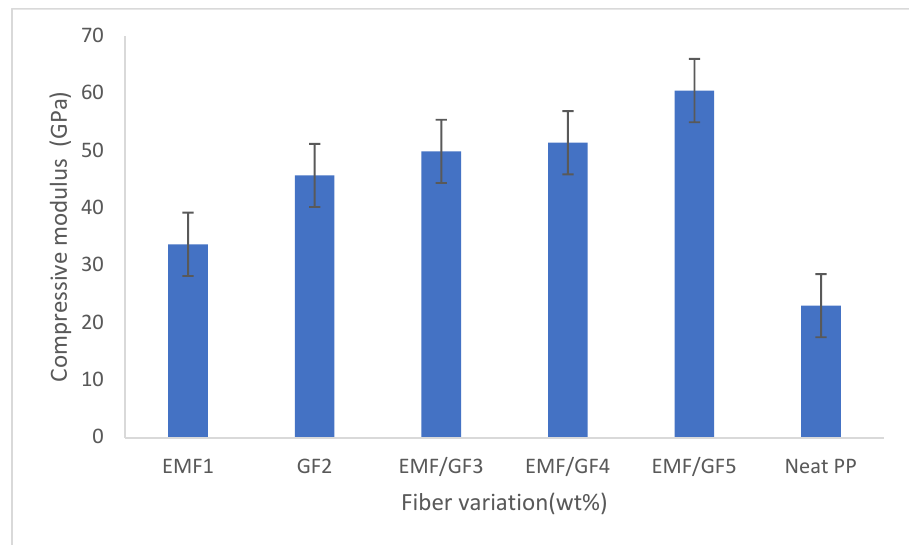
Figure 8. The compressive modulus of the composites.